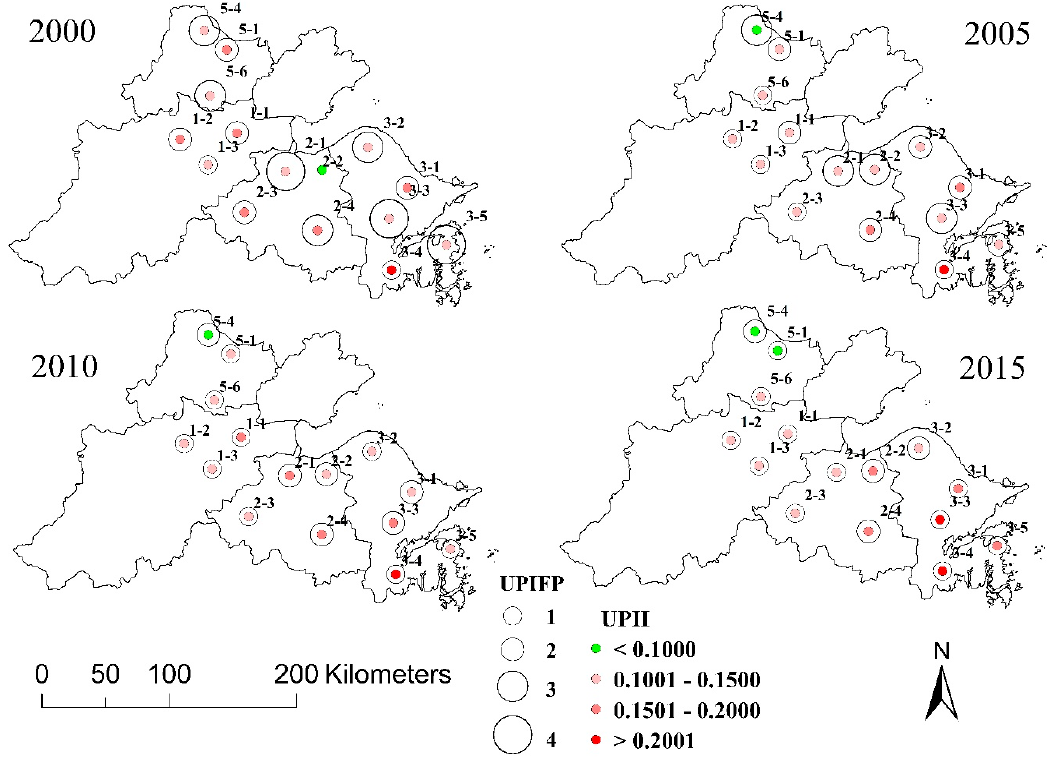
Figure 8. Spatial distribution of the UPI intensity (UPII) and UPI footprint (UPIFP) for the urban areas with UPI effects in 2000, 2005, 2010, and 2015.